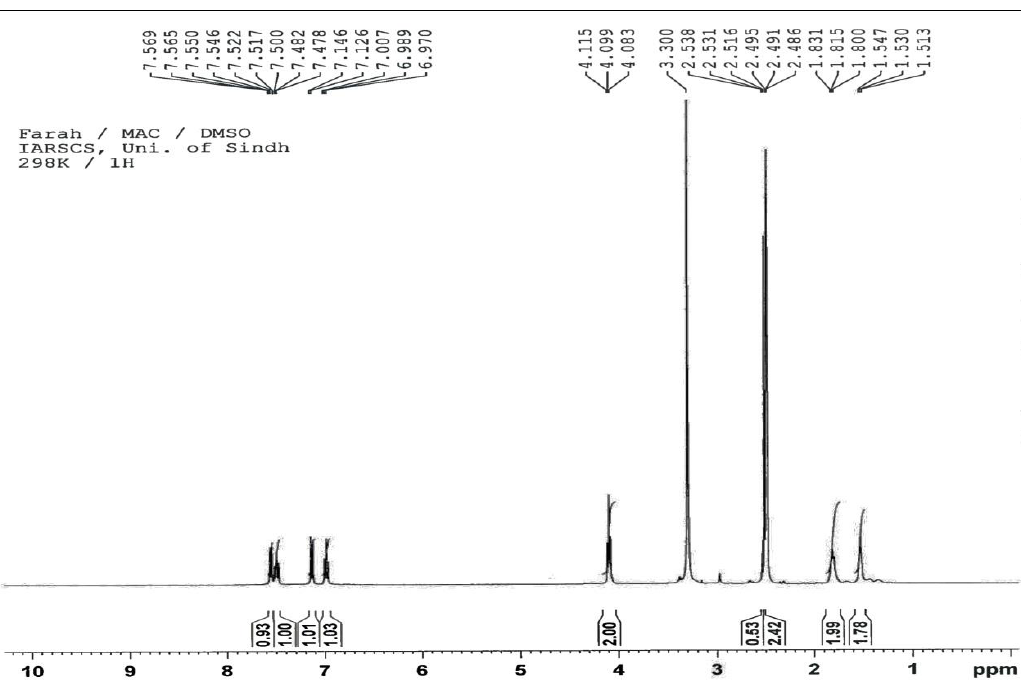
Figure S10: 1 HNMR spectrum of diketone monomer o